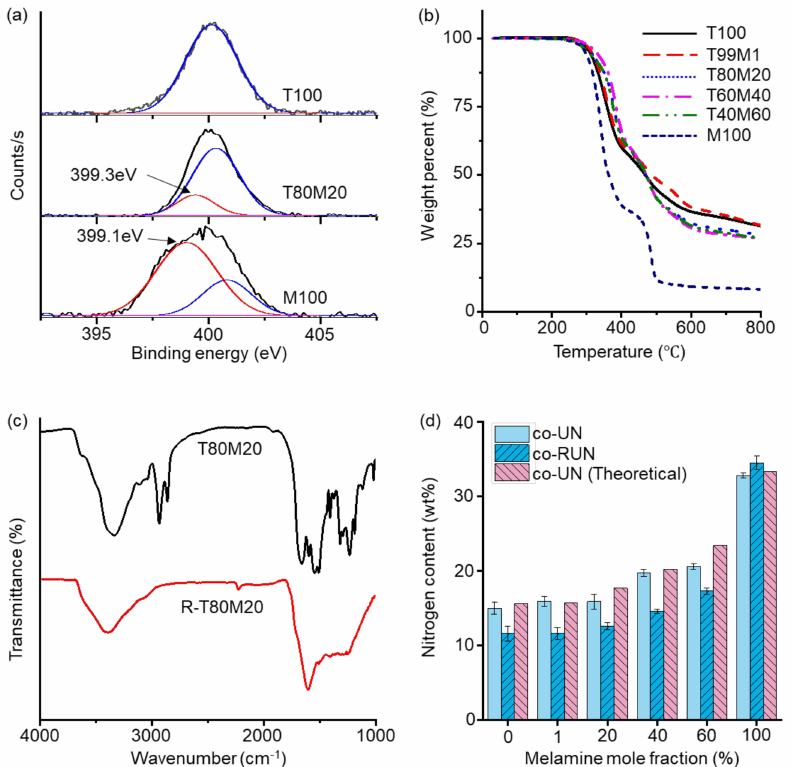
Figure 2. The transformation of the chemical structure from co-UNs into co-RUNs. ( a ) XPS N1s spec- tra of T100, T80M20, and M100 (red: triazine, blue: urea bond). ( b ) TGA curve of co-UNs. ( c ) FT-IR spectrum of T80M20 and R-T80M20. ( d ) Nitrogen content of co-UNs and co-RUNs, respectively, plotted against the molar ratio of the melamine in the amine monomer